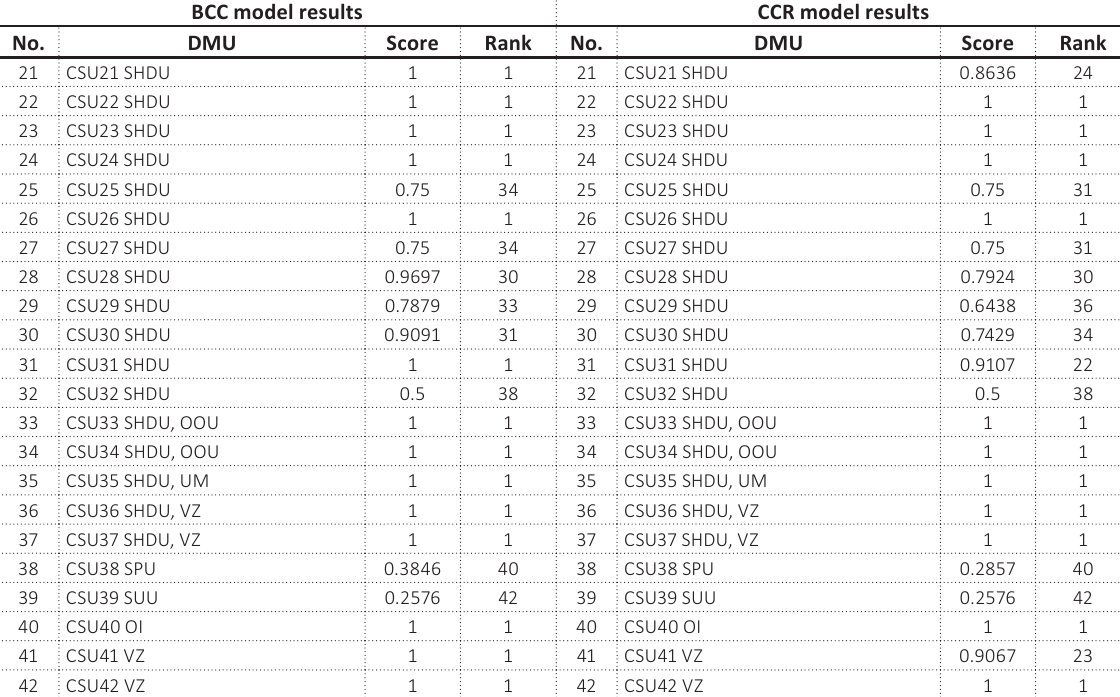
Table 2 (cont.). Efficiency results concerning basic models